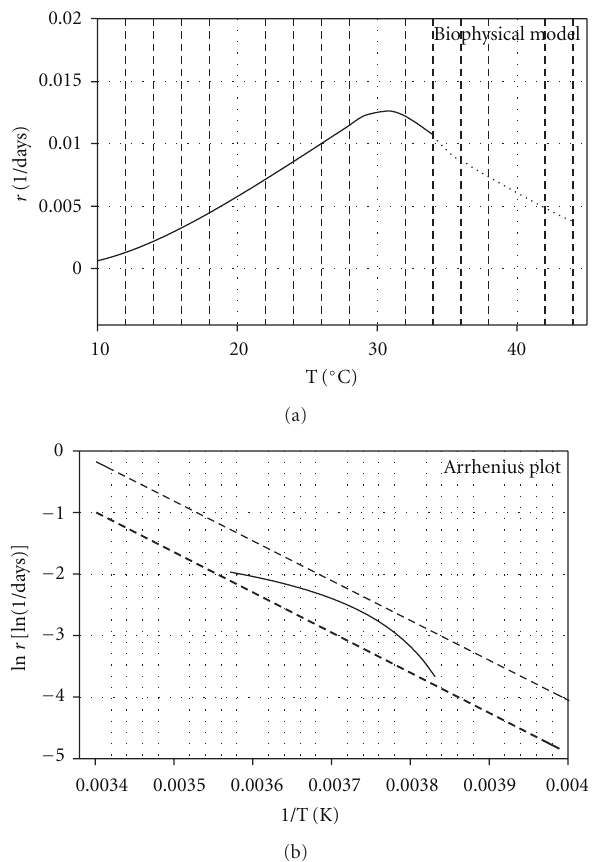
Figure 3: Curve shape of the biophysical model of sharp and DeMichelle [63] as modified by Schoolfield et al. [20] (a) and the respective Arrhenius plot